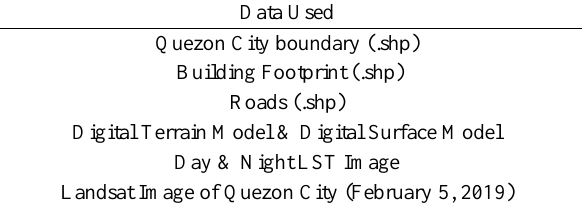
Table 2. Data Used in the